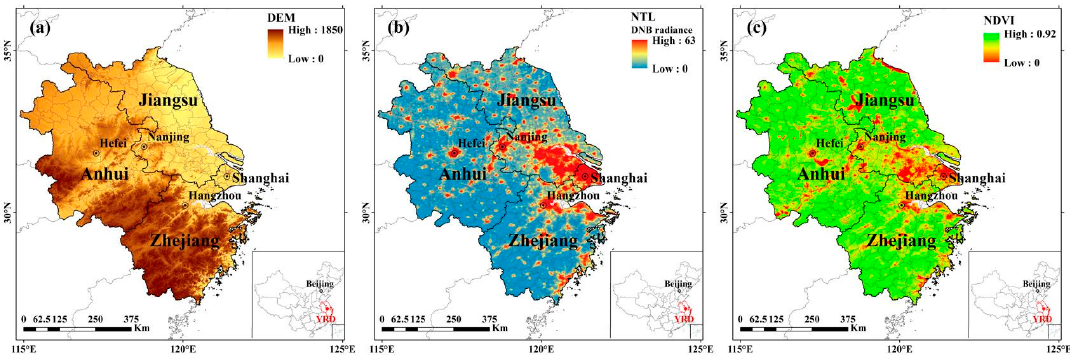
Figure 1. Spatial distribution in the Yangtze River Delta (YRD) region of the parameters ( a ) digital elevation model (DEM), ( b ) Day/Night Band (DNB) radiance of night-time-light (NTL), and ( c ) Normalized Difference Vegetation Index ( NDVI) at 1-km resolution.